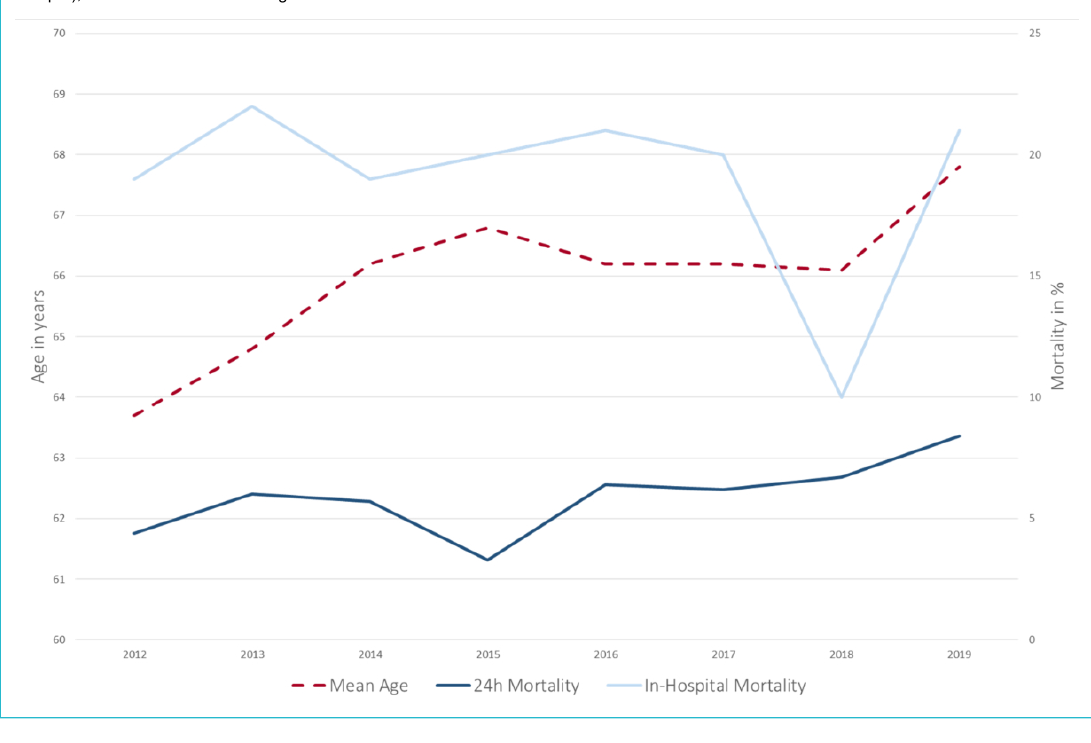
Figure 2: MET calls by hour of the day.Dark grey line: All MET calls; light grey line: MET calls on medical wards; dotted line: MET calls on sur- gical wards. Blue shades: half hour before and after nursing shift changes, red arrows indicate beginning and end of doctors’ day shifts (8 am to 5 pm), blue horizontal line: average of calls.